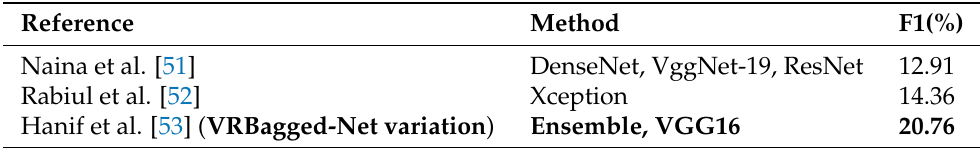
Table 5. FRMT Dataset: Comparison of VRBagged-Net with state-of-the-art methods.